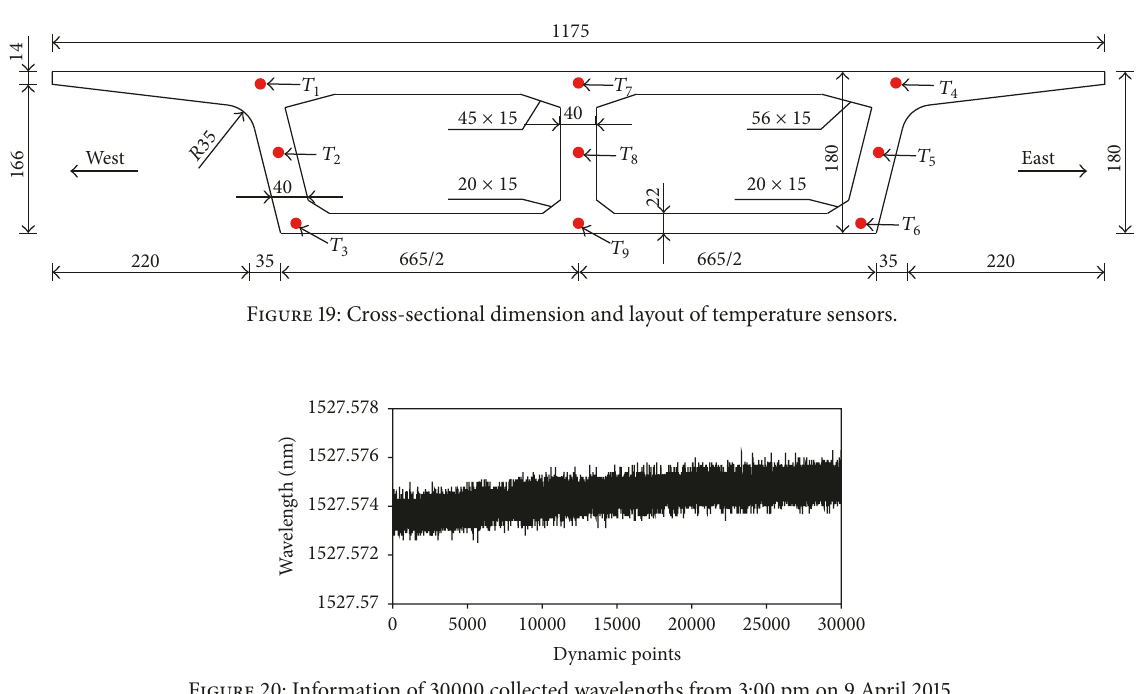
more consistent with Euler-Bernoulli beam theory relative to the test beam due to the geometrical properties and